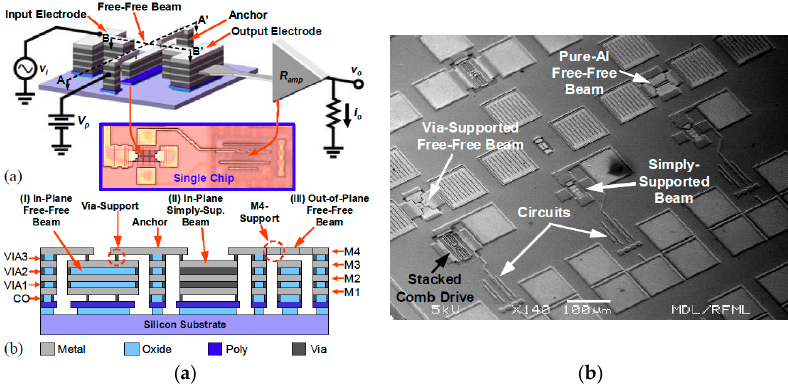
Figure 5. Illustrative structure and circuits of the radio frequency (RF) switch in [40] ( a ), and SEM photograph of the chip ( b ). Table 2. Some CMOS MEMS devices enabled by subtractive process wet etching.